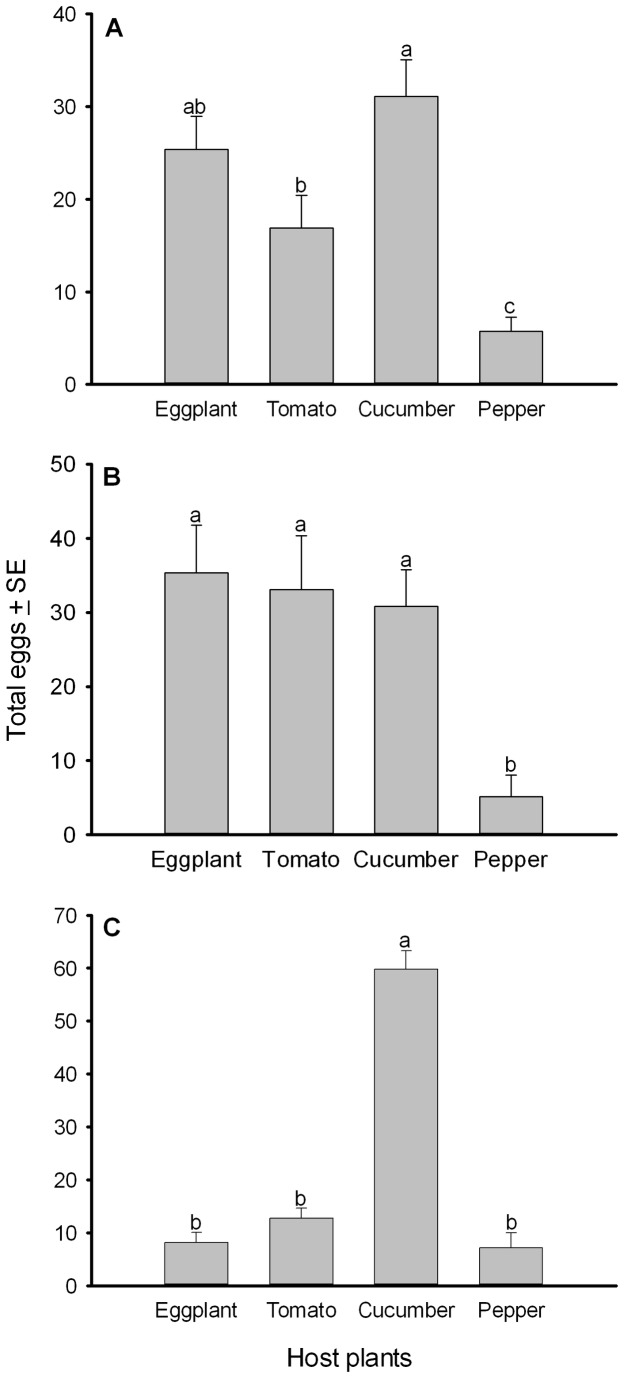
Number of B. tabaci eggs (mean ± SE) laid on leaf discs of the four host plants in a choice bioassay.A, B and C termed as total eggs laid by Bemisia-eggplant, Bemisia-tomato, and Bemisia-cucumber, respectively. Different letters above the error bars indicate significant difference at P ≤ 0.05, LSD.